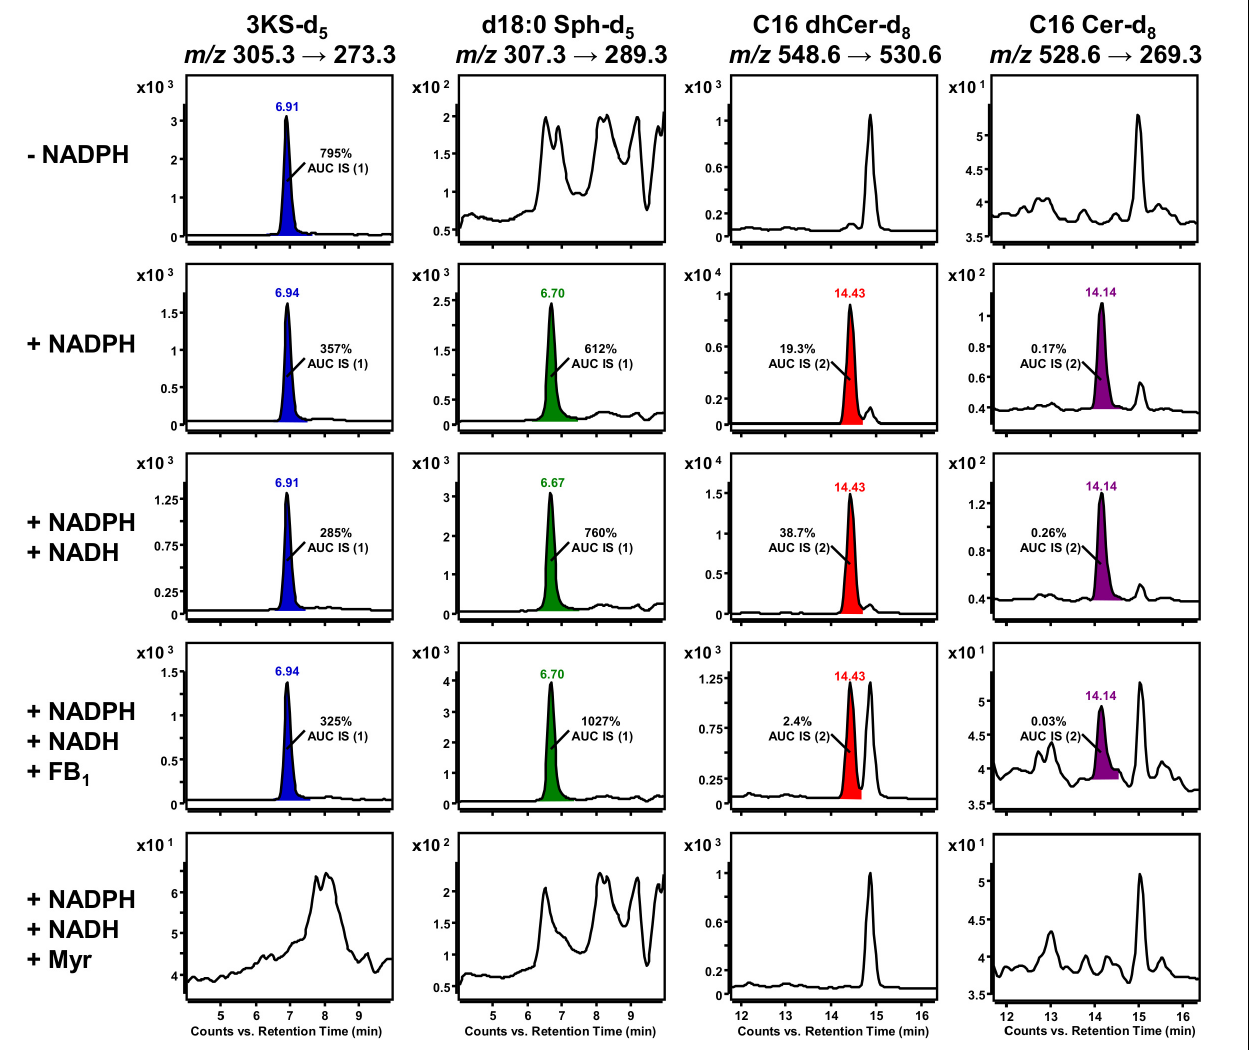
FIGURE 7 | Impact of cofactor supplementation and presence of enzyme inhibitors on de novo formation of deuterated sphingolipid metabolites in the microsomal assay. Selected reaction monitoring (SRM) using a triple quadrupole mass spectrometer (TQ MS) was conducted to investigate the formation of 3KS-d 5 (first column), d18:0 Sph-d 5 (second column), Cer d18:0-d 5 /16:0-d 3 (C16 dhCer-d 8 , third column) and Cer d18:1-d 5 /16:0-d 3 (C16 Cer-d 8 , fourth column) under different assay conditions. The in vitro assay reaction mixture was prepared as described in section Materials and Methods with the following modifications: omission of NADPH (first row), “standard conditions” (with NADPH, second row), supplemented with NADPH and NADH (third to fifth row), addition of ceramide synthase (CerS) inhibitor fumonisin B 1 (FB 1 , fourth row), and addition of serine palmitoyltransferase (SPT) inhibitor myriocin (Myr, fifth row). Signals that were not present in the corresponding negative controls were integrated and colored. d17:0 Sph (0.2 pmol injected on column) and Cer d18:1/17:0 (2 pmol injected on column), referred